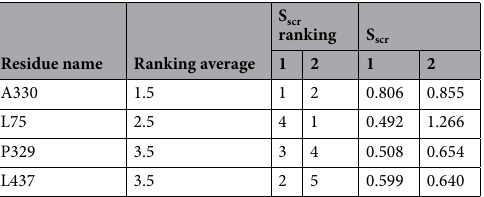
Table 1. S scr s and mutation site rankings for trans- carveol ( 12 ) based on S scr s.